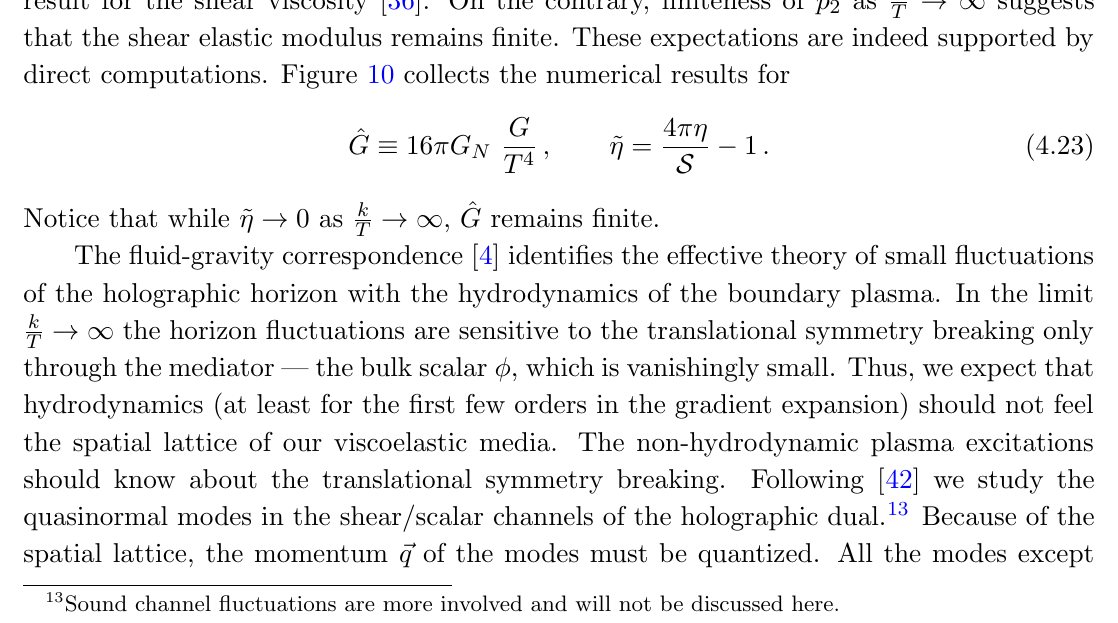
Figure 10 . Elastic shear modulus ^ G = 16 (cid:25)G N G=T 4 and the shear viscosity ~ (cid:17) = 4 (cid:25)(cid:17)= S (cid:0) 1 at (cid:12)xed (cid:14) 2 =T 2